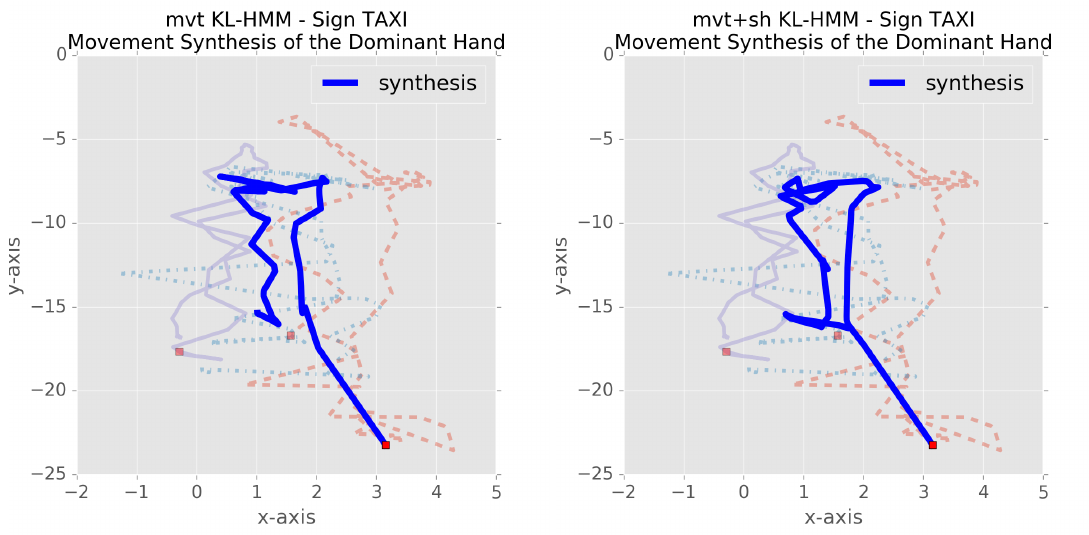
Figure 7. Movement synthesis of the dominant hand for the sign TAXI using the Gaussian distribution sequence computed from the hmvt KL-HMM system and the hmvt+hshp KL-HMM system. The red squares are the starting